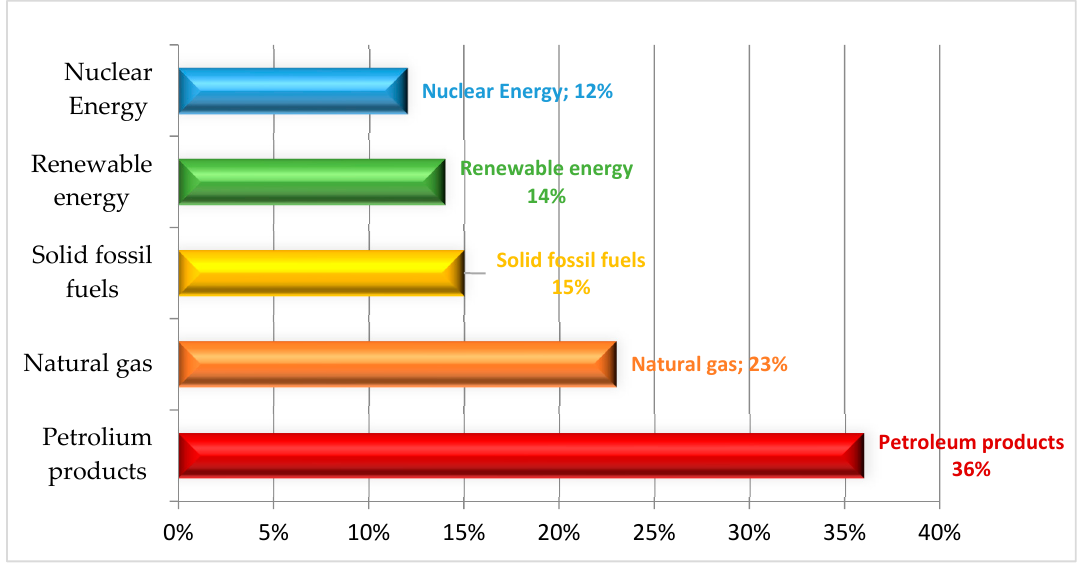
Figure 1. Energy mix produced in the European Union (EU) in 2017. Source: Statistical Office of the European Union (EUROSTAT) [30].